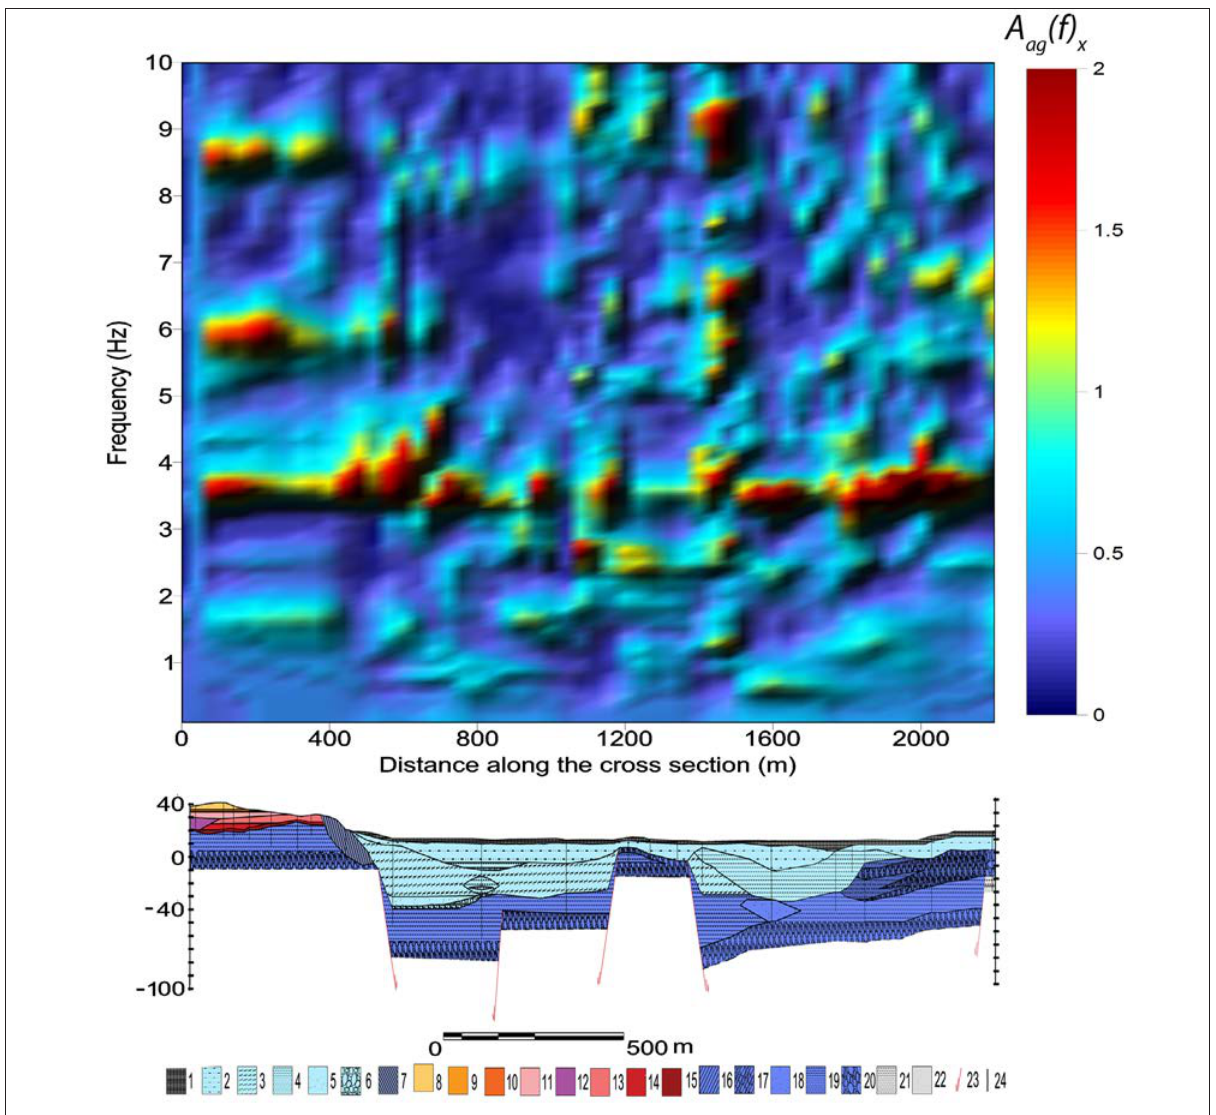
Figure 15. A (f) distribution (top) along the ancient Via Laurentina (bottom). See Figure 4 for the key to the ag x